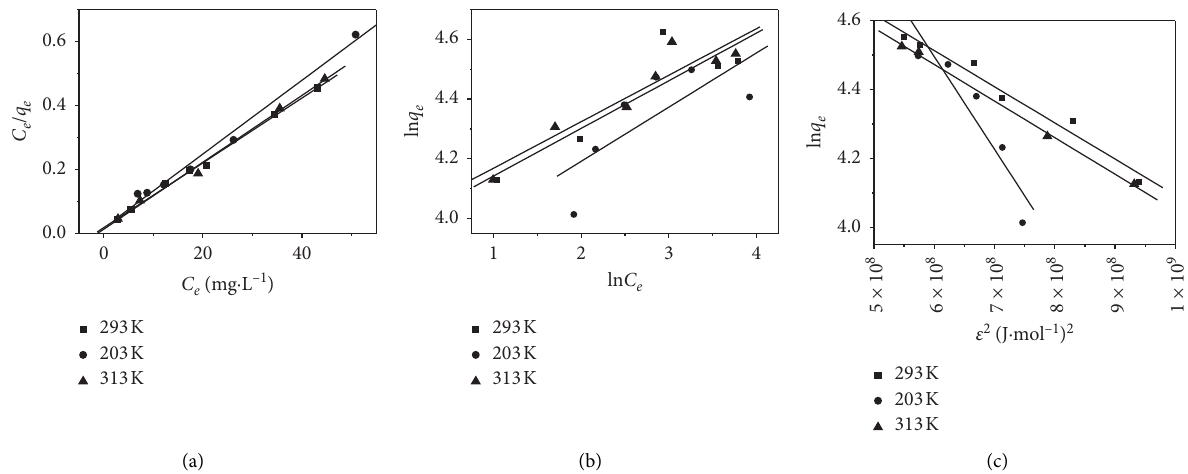
Figure 14: (a) Plots of Langmuir, (b) Freundlich, and (c) Dubinin – Radushkevich isotherms in linear form for the adsorption of phenol red onto FeCB at different